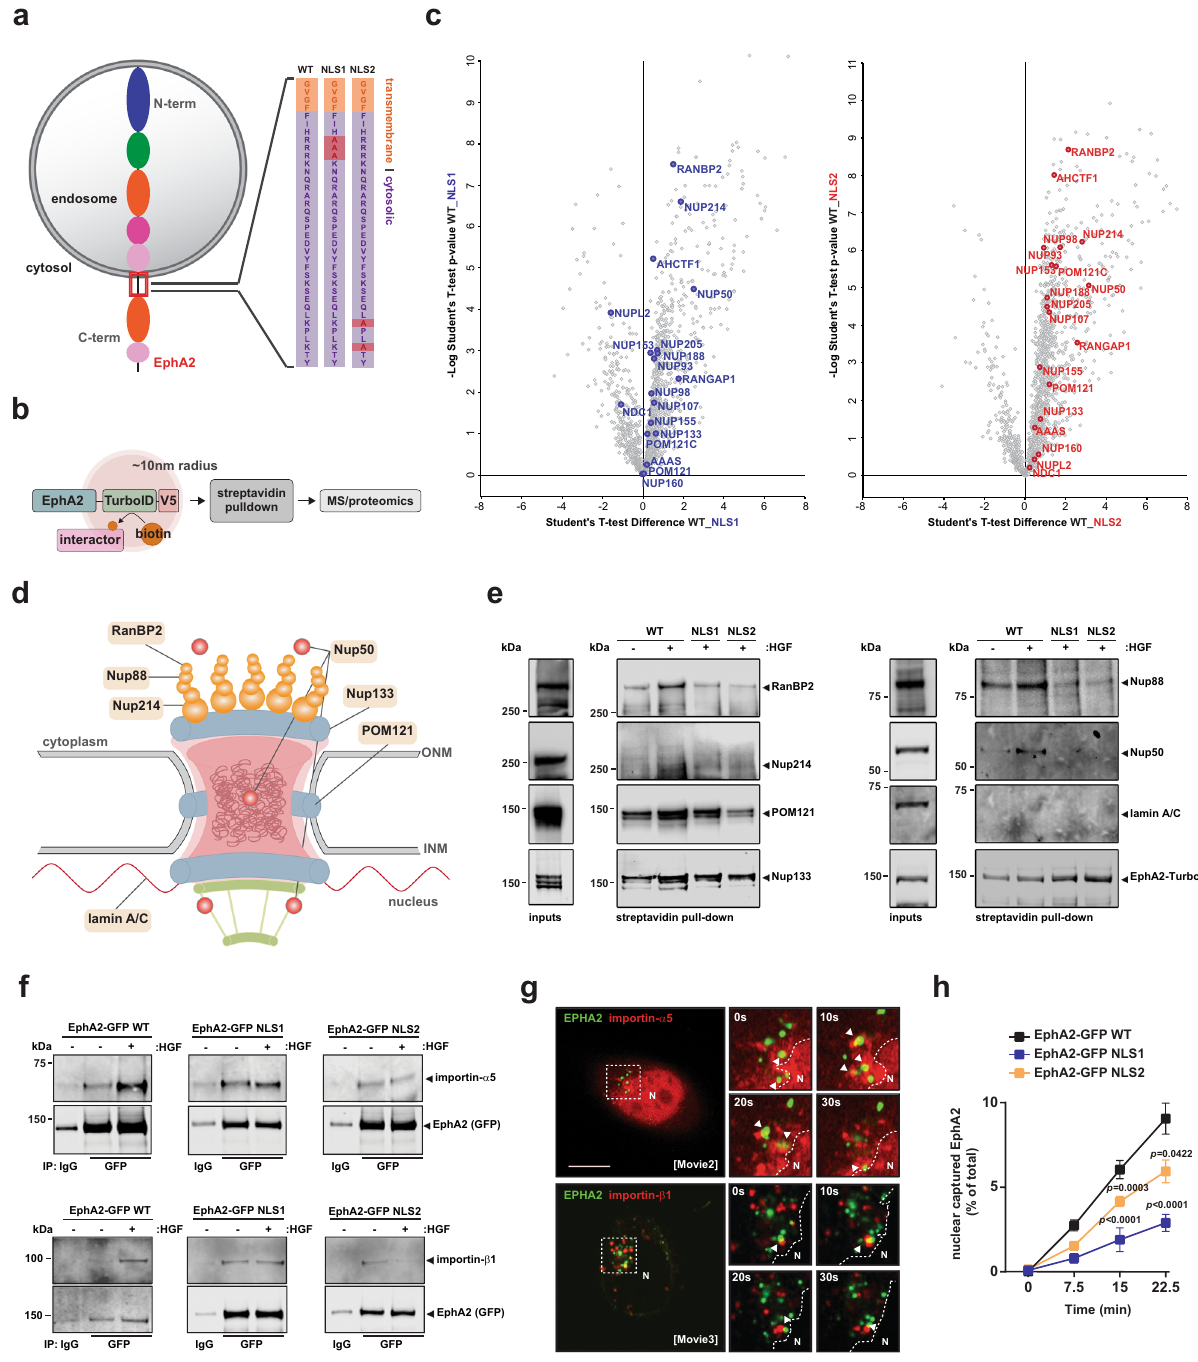
knocking down the exportin-6 transporter ( XPO6 ) (Supplemen- tary Fig. 4f, g), which mediates ef fl ux of G-actin from the nucleus 32 , HGF-driven transcription of MRTF target genes and cell scattering were inhibited (Supplementary Fig. 4h,